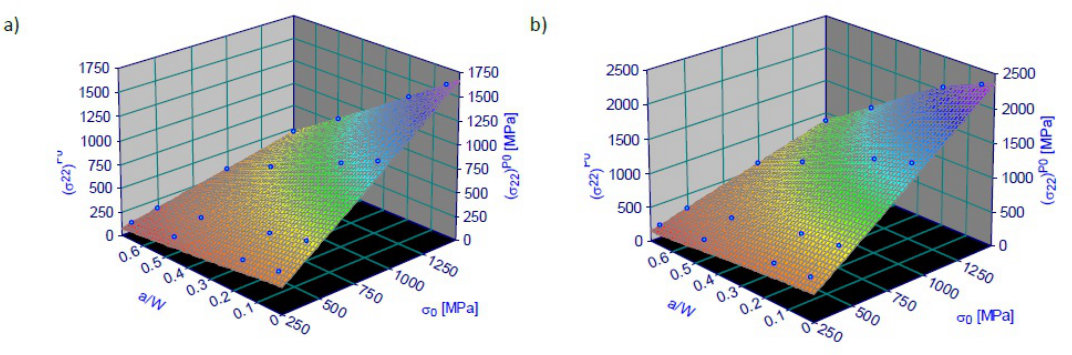
Figure 19: Relationship ( σ 22 ) P 0 = f ( σ 0 , a / W ) for the CCSP(BT) under conditions of a) predominant plane stress, σ 11 / σ 22 = 0.25; b) pre- dominant plane strain, σ 11 / σ 22 = 1.50; results presented for the fixed ratio σ 11 / σ 22 – ratio of biaxial external tensile stresses in the plate – diagrams used in the approximation of the numerical results for two-dimensional problems